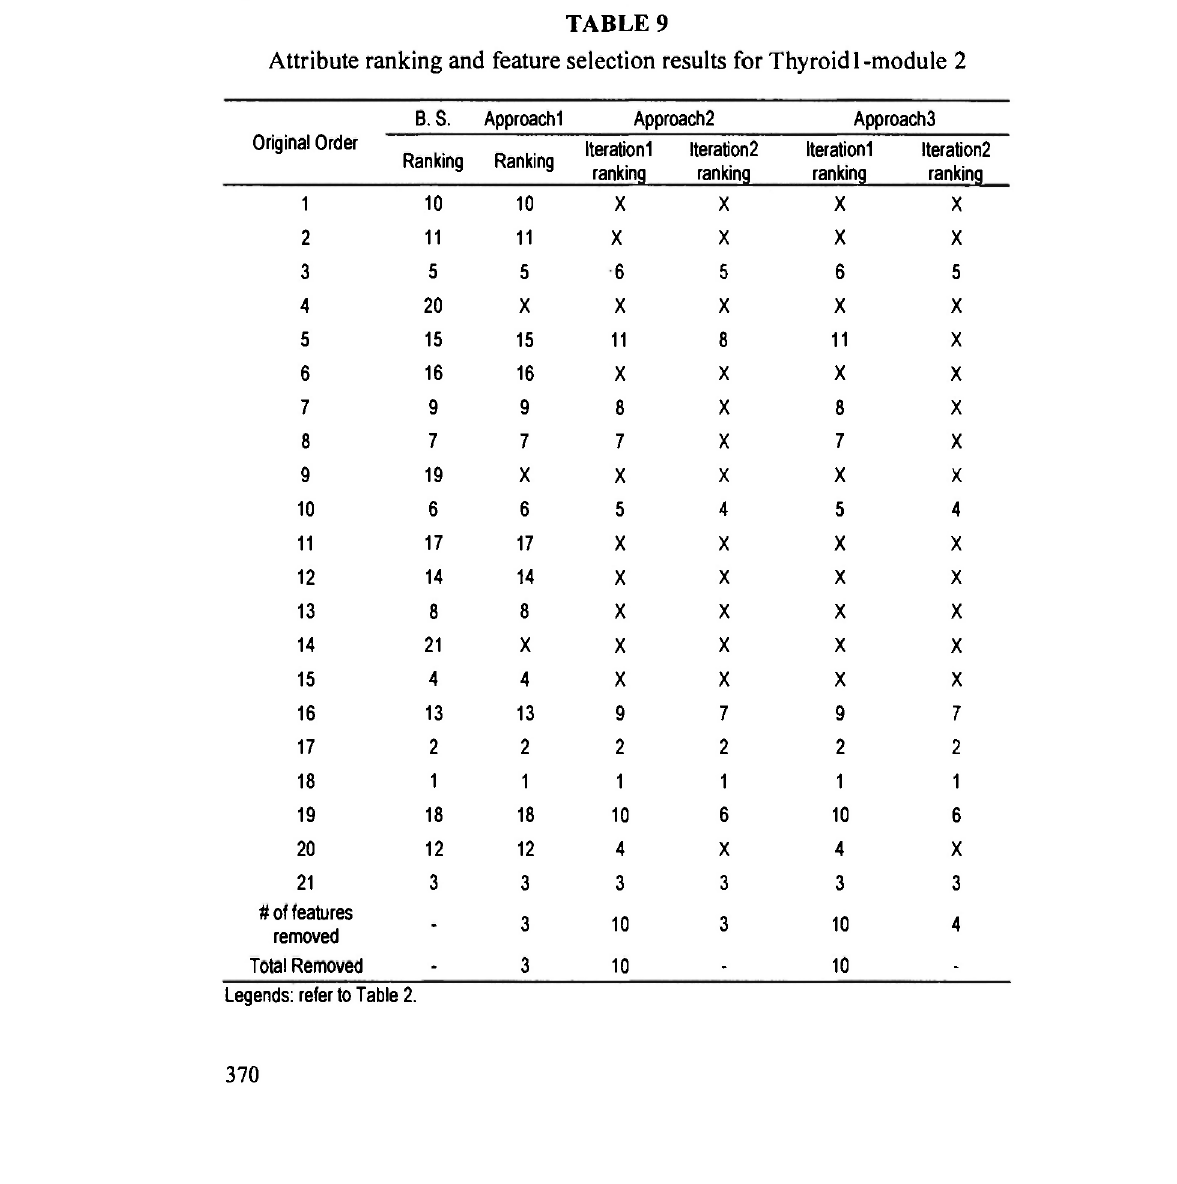
Attribute ranking and feature selection results for Thyroid 1-module 2 B.